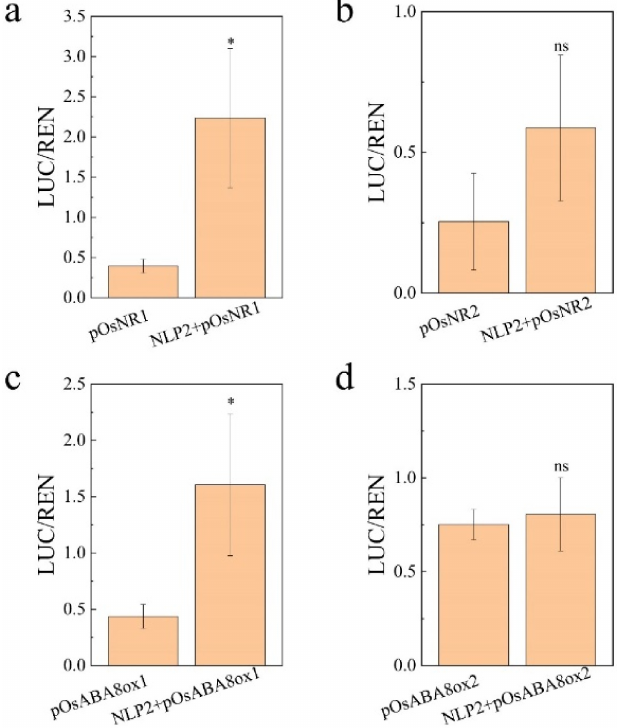
Figure 8. Transient trans-activation expression assays for NLP2 in rice protoplasts. ( a , b ) Transient trans-activation for NLP2 on OsNR1 and OsNR2 genes; ( c , d ) Transient trans-activation for NLP2